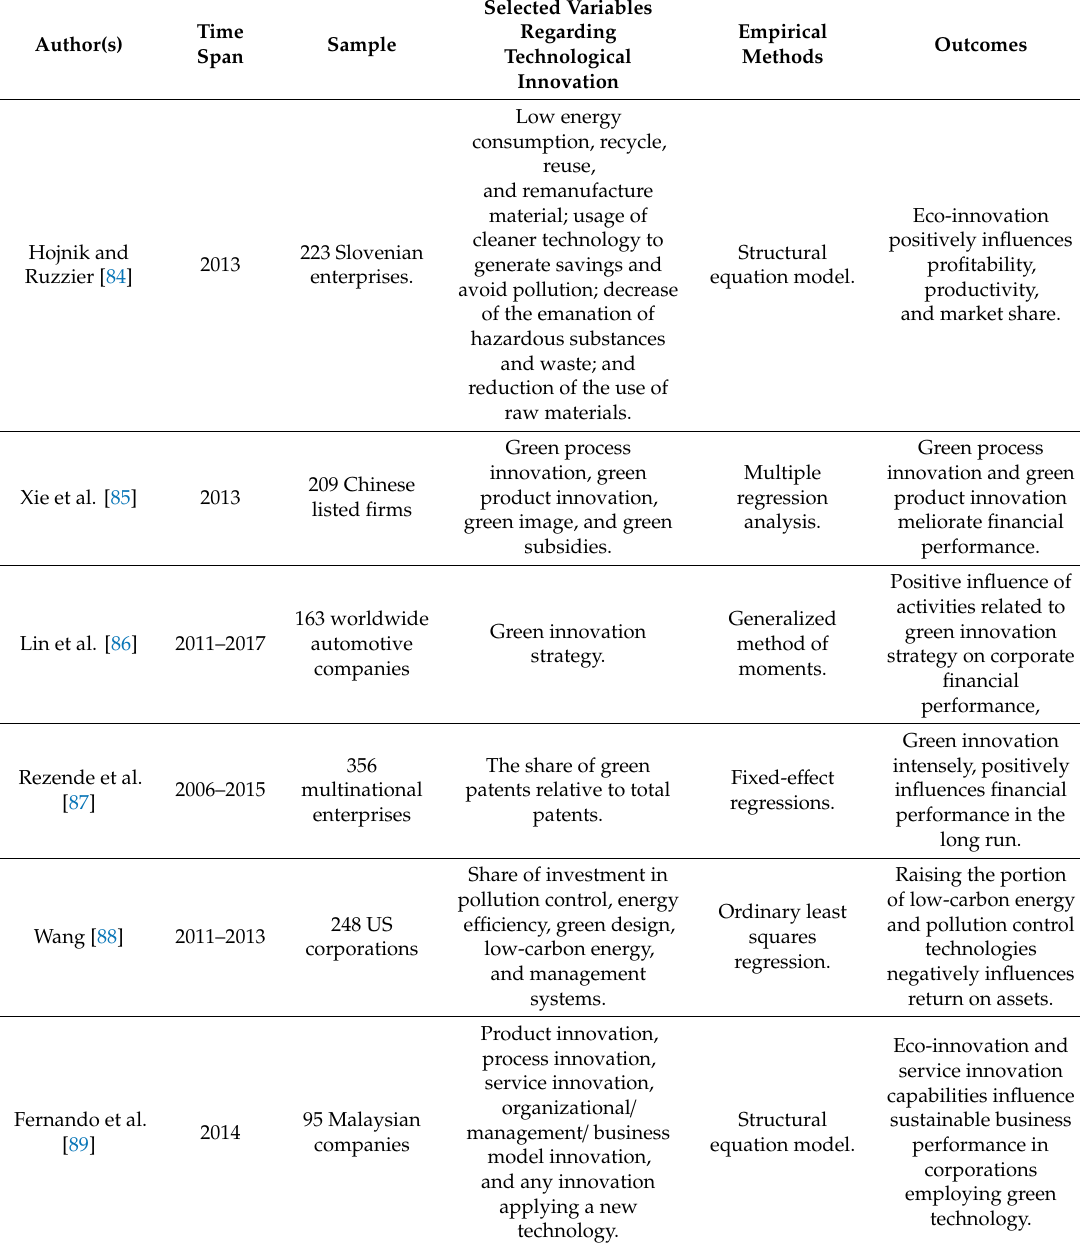
Table 2. Earlier research concerning the technological innovation-company performance